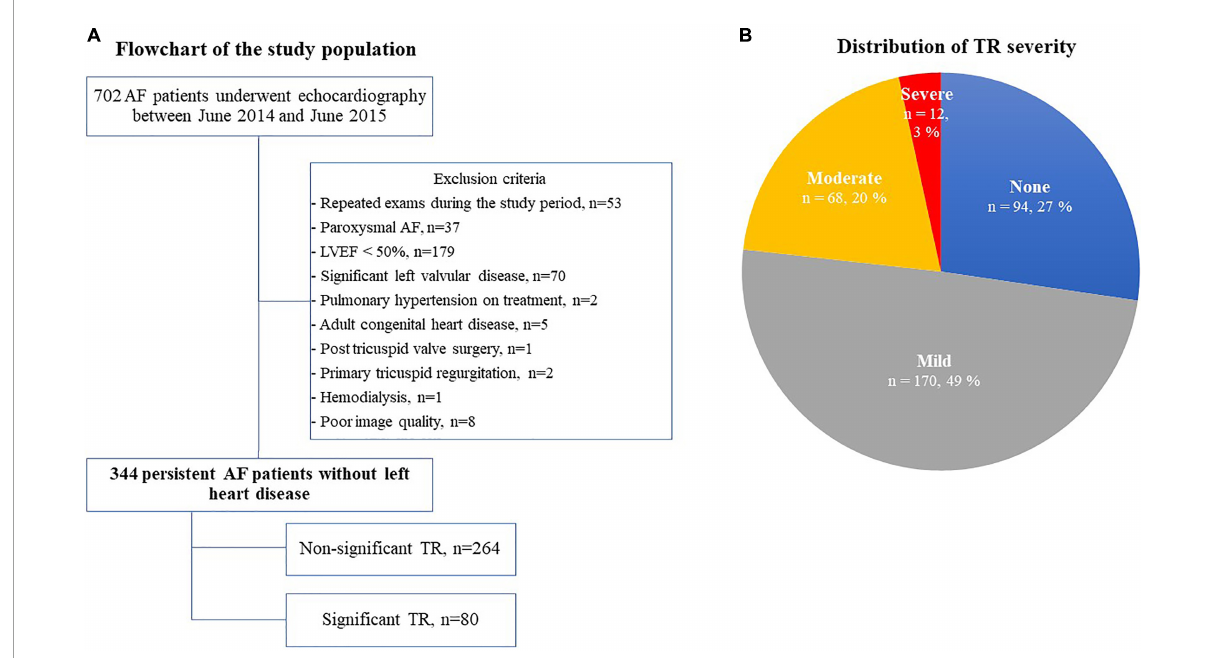
FIGURE1 Flow chart of the study population (A) and the distribution of TR severity (B) . AF, atrial fibrillation; LVEF, left ventricular ejection fraction; and TR, tricuspid